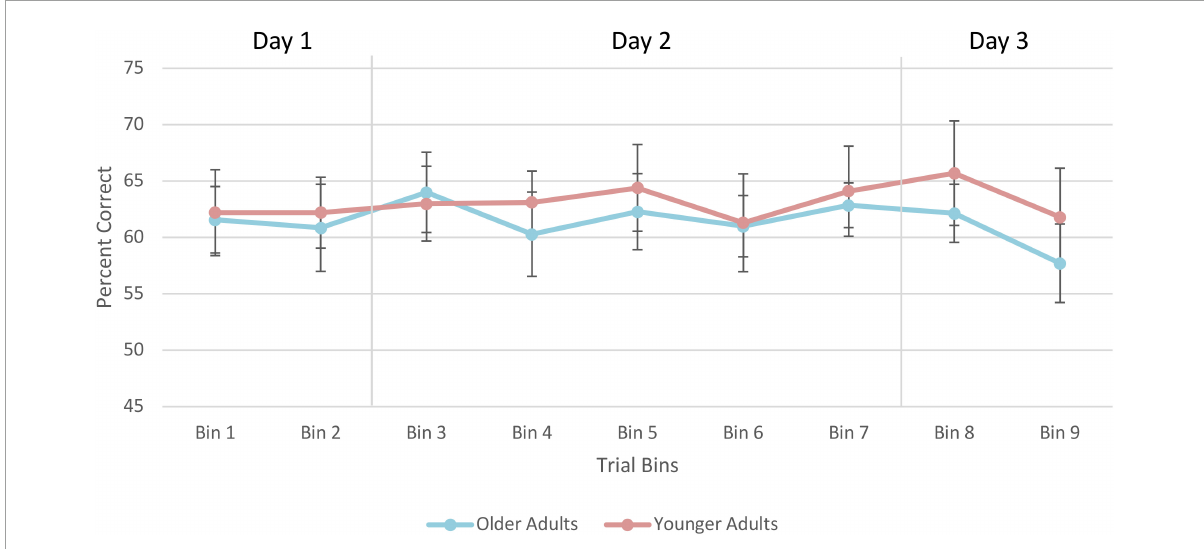
Biases Pre-training